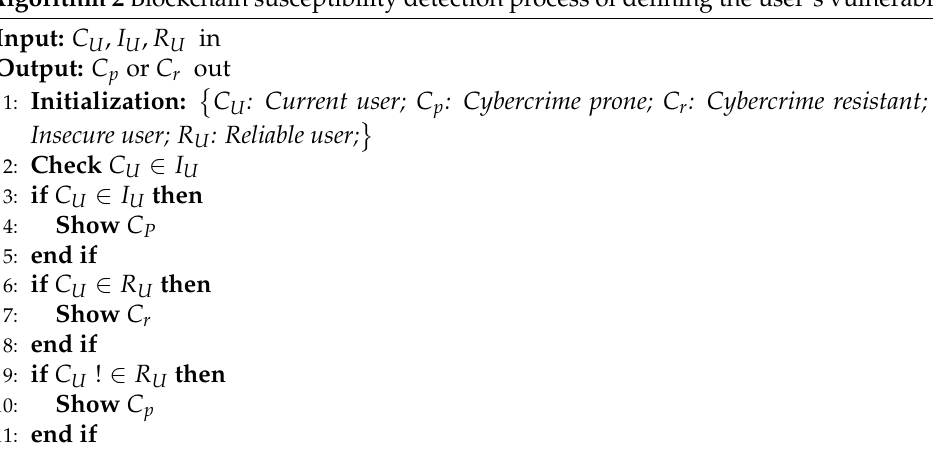
Figure 3. Blockchain-enabled susceptibility detection model for WBCA. Algorithm 2 Blockchain susceptibility detection process of defining the user’s